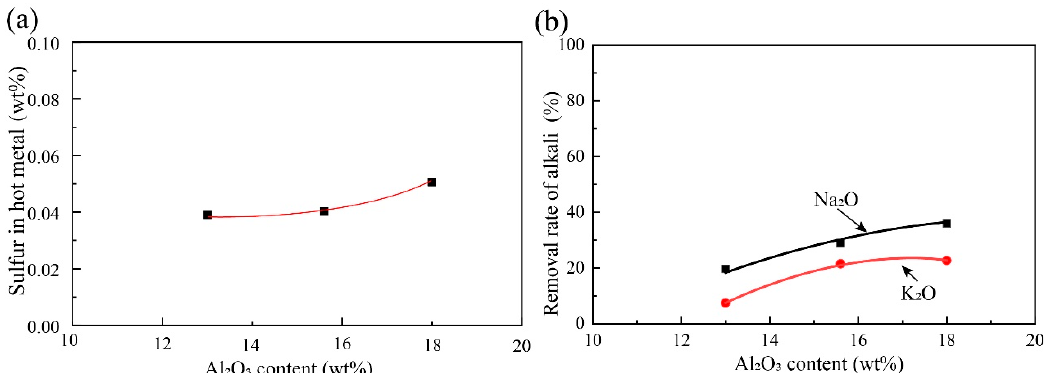
Figure 6. Effect of Al 2 O 3 content on the desulfurization and the removal of alkali at slag-to-metal ratio of 200 kg/t ( a ) Desulfurization; ( b ) the removal of alkali.